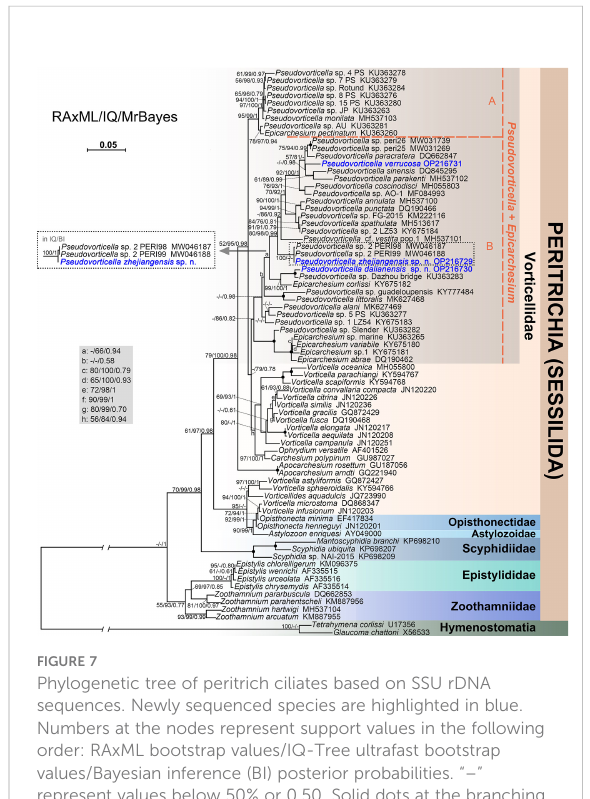
FIGURE 7 Phylogenetic tree of peritrich ciliates based on SSU rDNA sequences. Newly sequenced species are highlighted in blue. Numbers at the nodes represent support values in the following order: RAxML bootstrap values/IQ-Tree ultrafast bootstrap values/Bayesian inference (BI) posterior probabilities. “–” represent values below 50% or 0.50. Solid dots at the branching point indicate full support from all algorithms (100%/100%/1.00). The scale bar indicates fi ve substitutions per 100 nucleotide